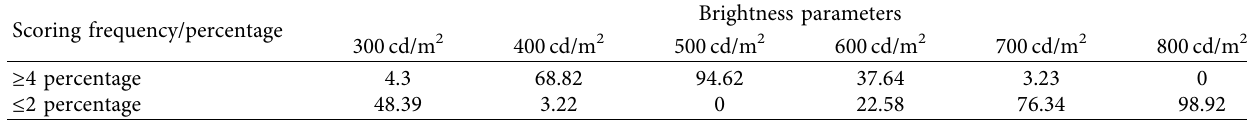
Table 4: Calculation table of threshold limit value of visual clarity brightness change data.